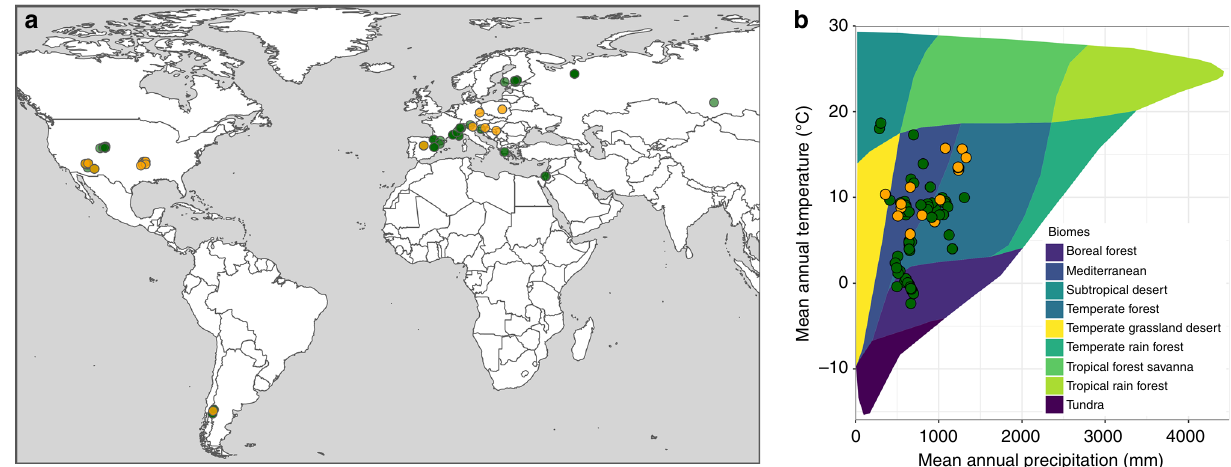
Fig. 1 Spatial and climatic ranges of the study. a Geographical distribution and b Whittaker biome classi fi cation for the study sites. The angiosperm (orange) and gymnosperm (green) tree species included in the analysis are depicted (see Supplementary Data 1 for the description of the